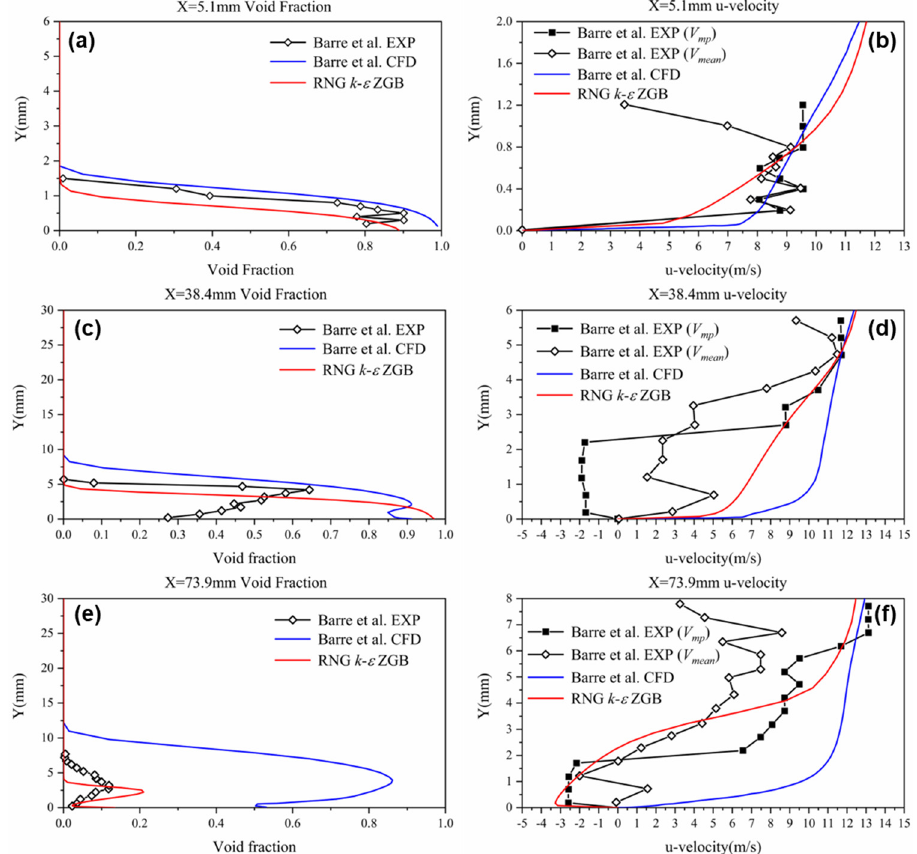
Figure 2. Void fraction and u-velocity profile: comparisons between experimental data and numerical results. ( a ) void fraction at X = 5.1 mm, ( b ) u-velocity at X = 5.1 mm, ( c ) void fraction at X = 38.4 mm, ( d ) u-velocity at X = 38.4 mm, ( e ) void fraction at X = 73.9, ( f ) u-velocity at X = 73.9 mm.